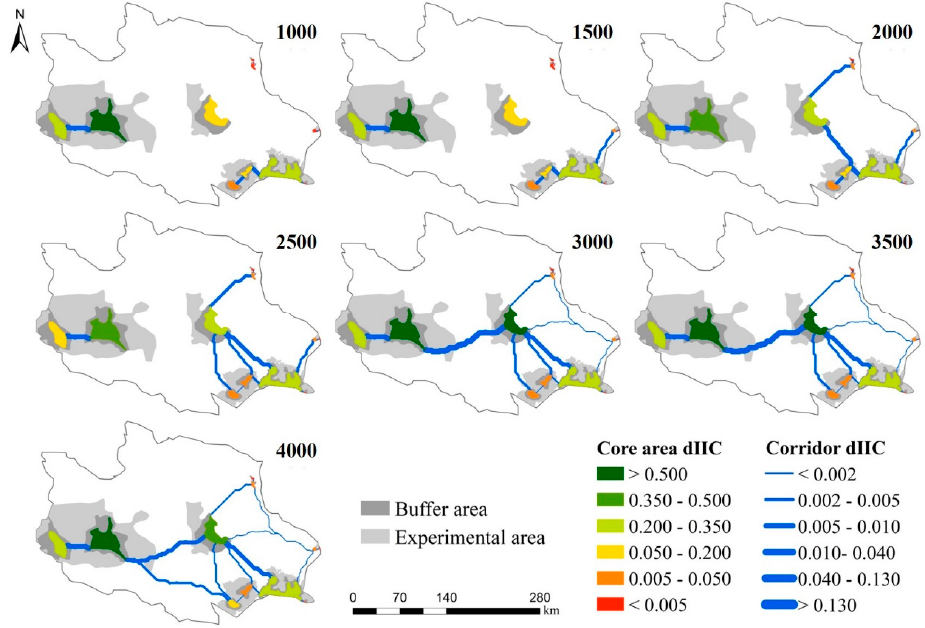
Figure 6. Ecological networks under different resistance thresholds. dIIC represents the importance of patches and corridors calculated by integral index of connectivity